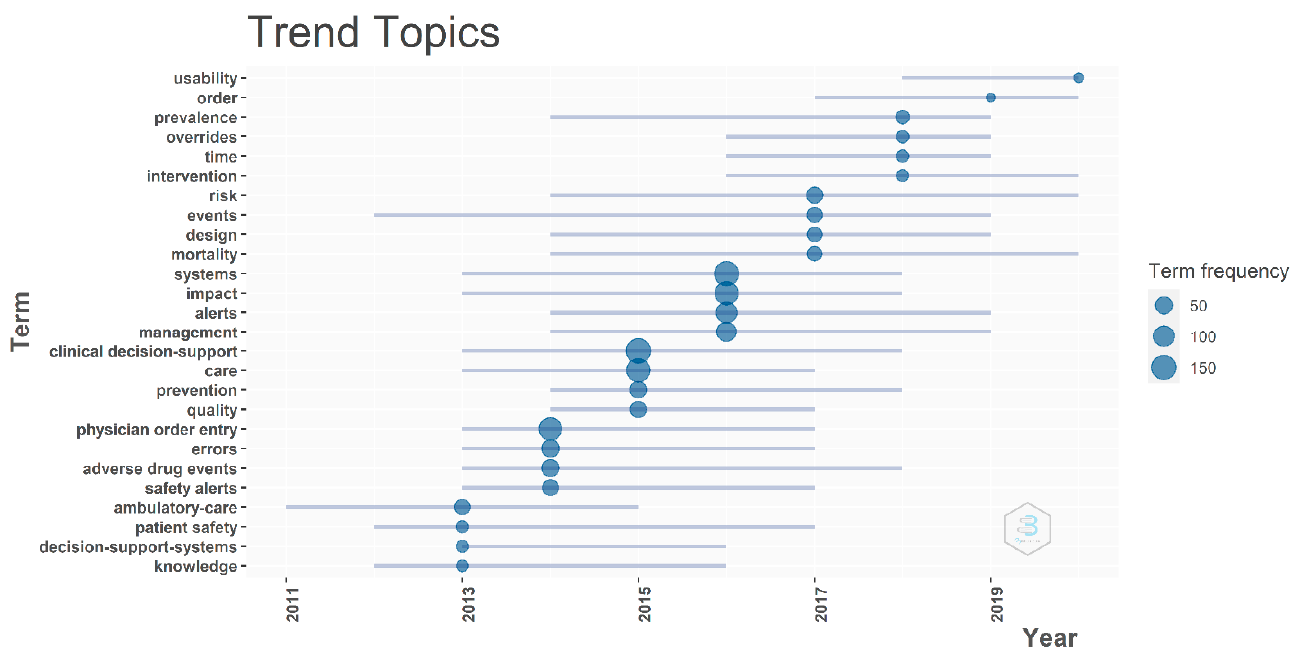
Figure 3. Core keywords analysis for trending topics.